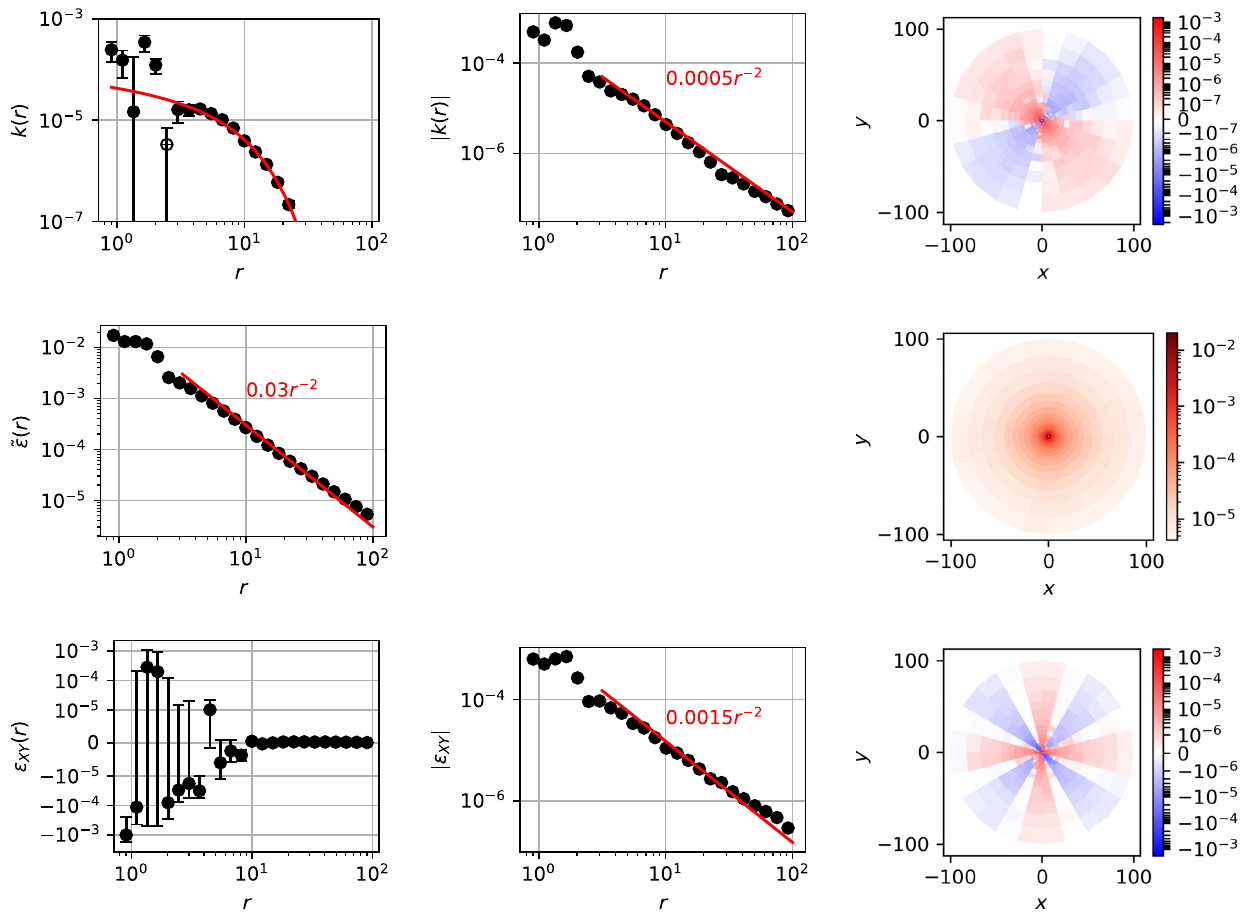
FIG. 3. Mean volumetric strain k (top row), mean deviatoric strain ˜ ϵ (middle), and mean shear strain in the xy direction (the direction of the global shear) ϵ (bottom) per frame caused by a rearranging particle at the origin. Angular-averaged (left-hand column), angular- xy averaged absolute value (middle), and angular (right) versions are shown. Note that the middle row and column plot is not shown because ˜ ϵ is always non-negative. In the top left-hand plot, solid circles represent positive values of k ð r Þ , while open circles represent negative values. Red lines are fits to continuum-elasticity predictions detailed in the text and Appendixes [Appendix A for j k ð r Þj , ˜ ε ð r Þ , ð r Þj ; and Appendix B for k ð r Þ and j ε xy